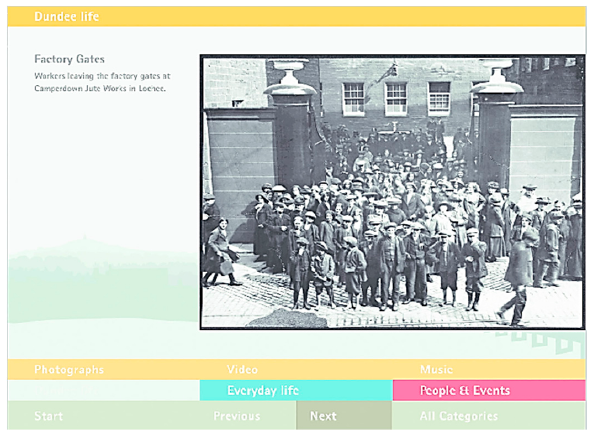
Figure 1. An example of a typical photograph included in Computer Interactive Reminiscence and Conversation Aid (CIRCA).